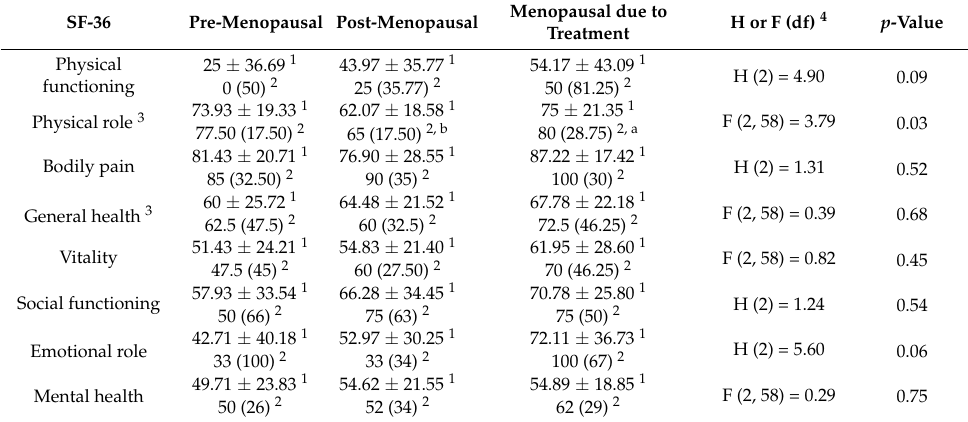
Table 5. Significant effects of menopause status on SF-36 subscales.